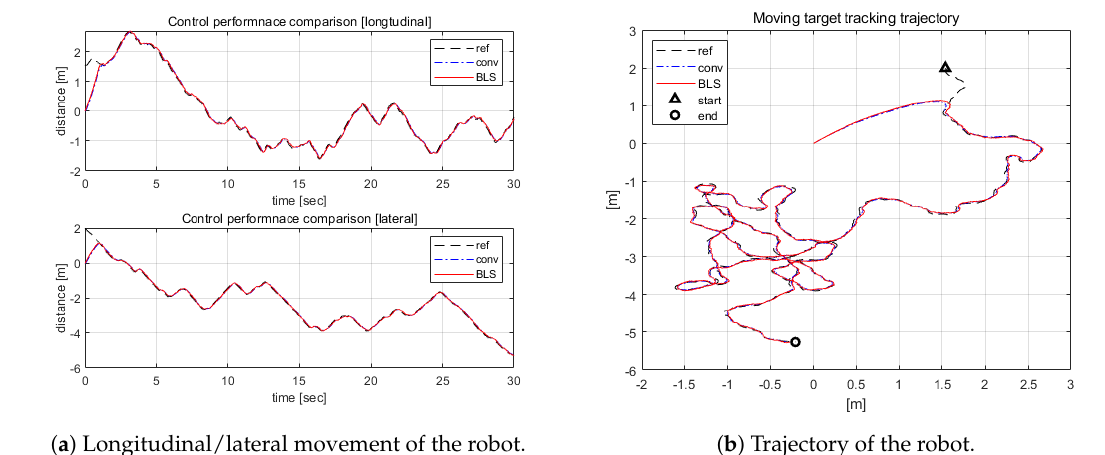
Figure 10. Random movement of the OWMR.